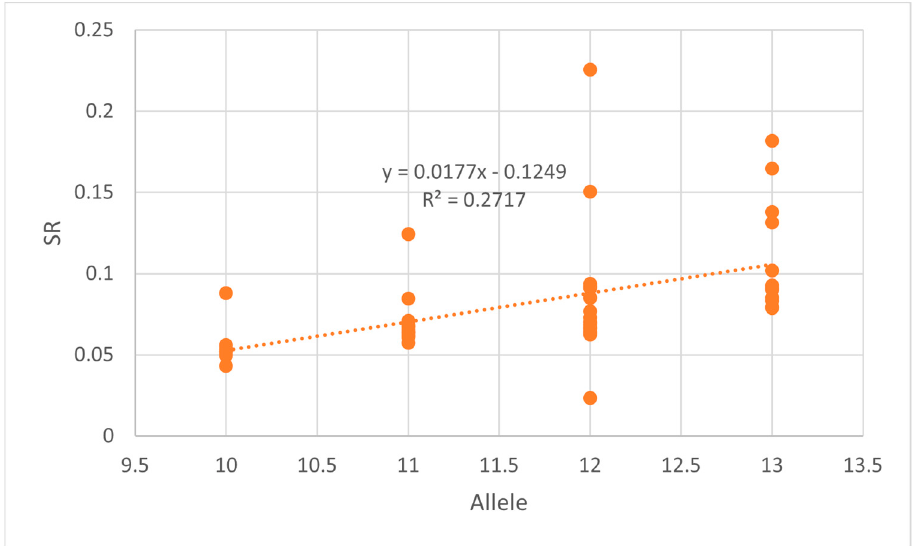
Figure 2. DSCS D16S539 back stutter.